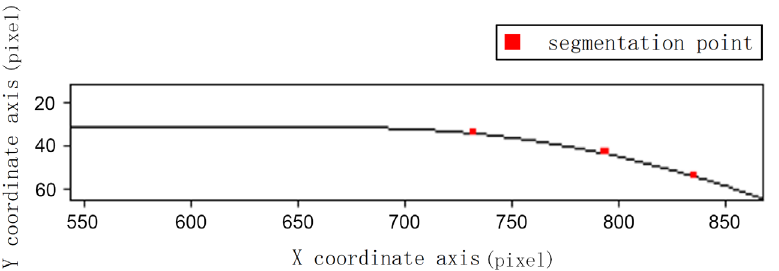
Figure 10. Deviation in the positions of the segmentation points at the tangent point of the great circle.